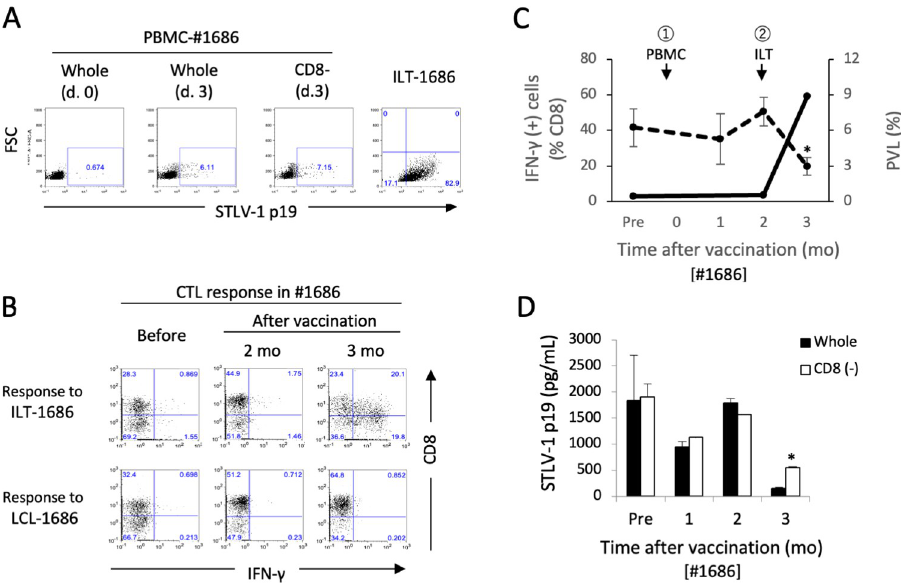
Fig 4. Vaccination of monkey #1686 with autologous STLV-1-infected cells. A. Intracellular STLV-1 expression was analyzed by flow cytometry following staining of the PBMCs from monkey #1686 with GIN7 monoclonal antibody before culture (whole d. 0) or after culturing for 3 days without fractionation (whole d. 3) or following CD8 + cell- depletion (CD8 - d. 3), and in ILT-1686 cells. B. Monkey #1686 was first subcutaneously inoculated with MMC-treated 5 × 10 6 autologous CD8 + cell-depleted PBMCs that had been cultured for 3 days, and secondarily inoculated with 1 × 10 6 MMC-treated ILT-1686 cells 2 months later. CTL responses against ILT-1686 (top) or LCL-1686 (bottom) in PBMC samples before and after immunization were analyzed by cytokine flow cytometry as described in the Methods. C. The proportion of IFN- γ -producing cells (% in CD8 + cells) upon stimulation with ILTs in B (consistent line) and the PVLs in the PBMCs (dotted line) before and after vaccination are summarized. The arrows indicate the time points of vaccination with autologous PBMCs or ILTs. D. PBMCs were cultured for 7 days without fractionation (closed bar) or after CD8 + cell depletion (open bar), and the STLV-1 p19 concentrations in their supernatants were measured by ELISA. The values indicate the mean and SD of duplicate samples. � p < 0.05.